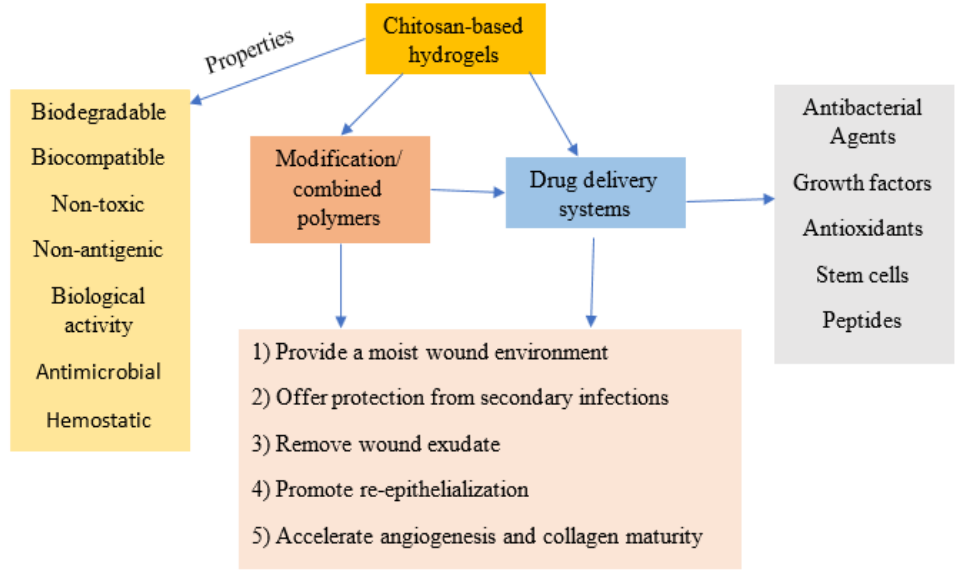
Figure 4. Summary of applications of chitosan-based hydrogels as both wound dressing and drug delivery systems.